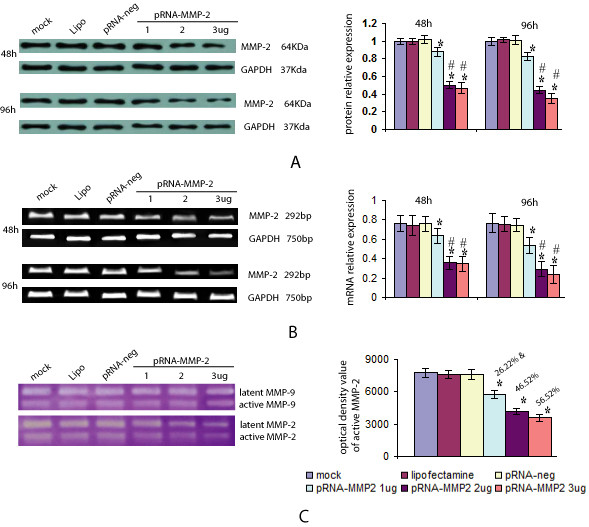
Effect of MMP-2 siRNA on ameloblastoma cells. Ameloblastoma cells were transfected with mock, lipofectamine, pRNA-neg, pRNA-MMP-2 (1 μg), pRNA-MMP-2 (2 μg), and pRNA-MMP-2 (3 μg) for the indicated times. GAPDH was used as an internal control to normalize the amounts of protein or mRNA. The relative protein or mRNA level of MMP-2 was depicted as the ratio of the density of MMP-2 to GAPDH for the same time point. The results shown are representative of triplicate experiments. *Compared with the mock, lipifectamine or vector controls, respectively, p < 0.05; #Compared with the 1 μg plasmid transfection group, p < 0.05. (A) Western blots were used to analyze MMP-2 protein levels in MMP-2 siRNA-transfected ameloblastoma cells. MMP-2 siRNA transfection decreased MMP-2 protein expression levels in a dose- and time-dependent manner compared with mock and scrambled vector controls. (B) RT-PCR was employed to detect the transcription of MMP-2 after MMP-2 siRNA transfection. Transcript levels of MMP-2 in MMP-2 siRNA-transfected cells were significantly reduced in a dose- and time-dependent manner compared with cells transfected with mock and lipofectamine and pRNA-neg. (C) Zymographic analysis for MMP-2 activity in the conditioned medium of ameloblastoma cells transfected with pRNA-MMP-2 for 96 h. Both latent and active form of MMP-2 and MMP-9 were detected in the gelatin zymogram. MMP-2 siRNA transfection inhibited MMP-2 activity in a dose-dependent manner in ameloblastoma cells.